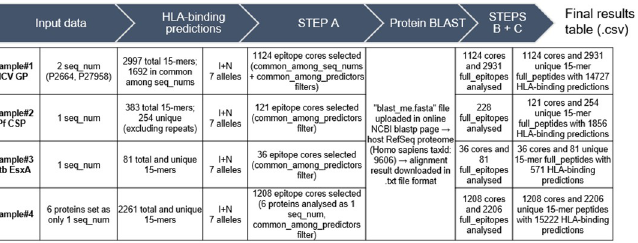
Fig 2. Results for HLA-class II T-cell epitope selection with SILVI on the 4 example proteins. I, IEDB MHC-II binding (consensus) algorithm; N, NetMHCIIpan.